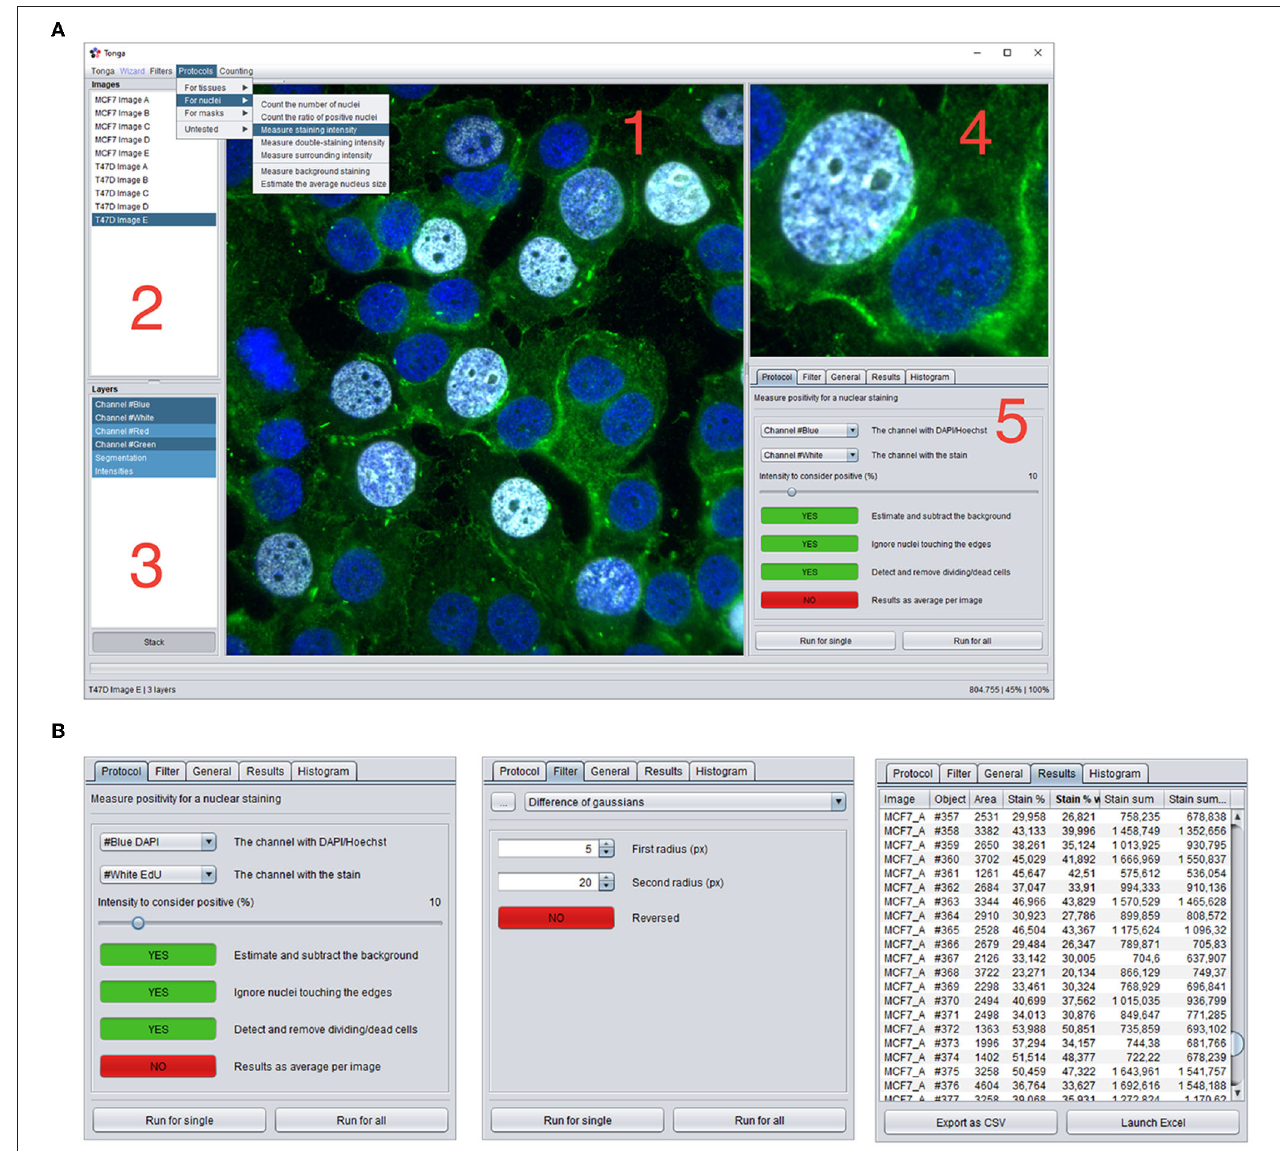
FIGURE 1 | Overview of the Tonga user-interface. (A) Main user-interface of Tonga. 1: Main image panel, 2: List of imported images, 3: List of layers (channels and processed versions of images) 4: Zoom panel, 5: Tab panel. Dropdown menus for lauching filters, protocols and counting functions. (B) Examples of the content of the Protocols, Filters, and Results Tab